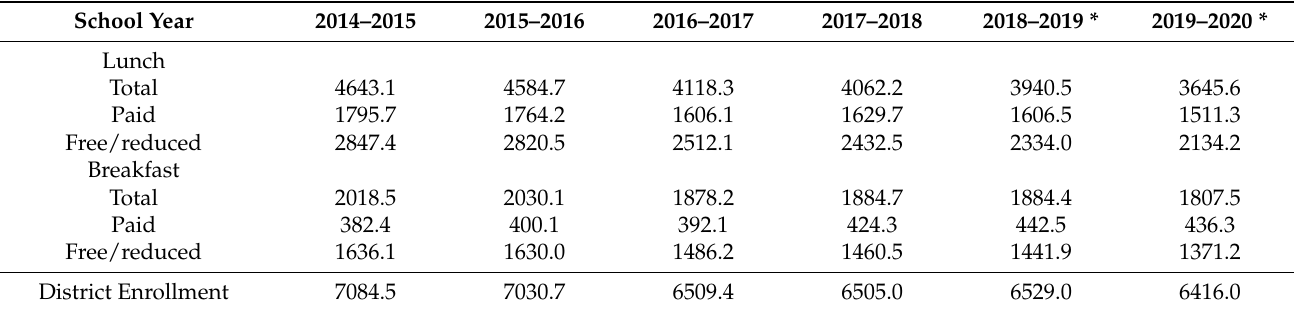
Table 2. Average number of served lunches and breakfasts per